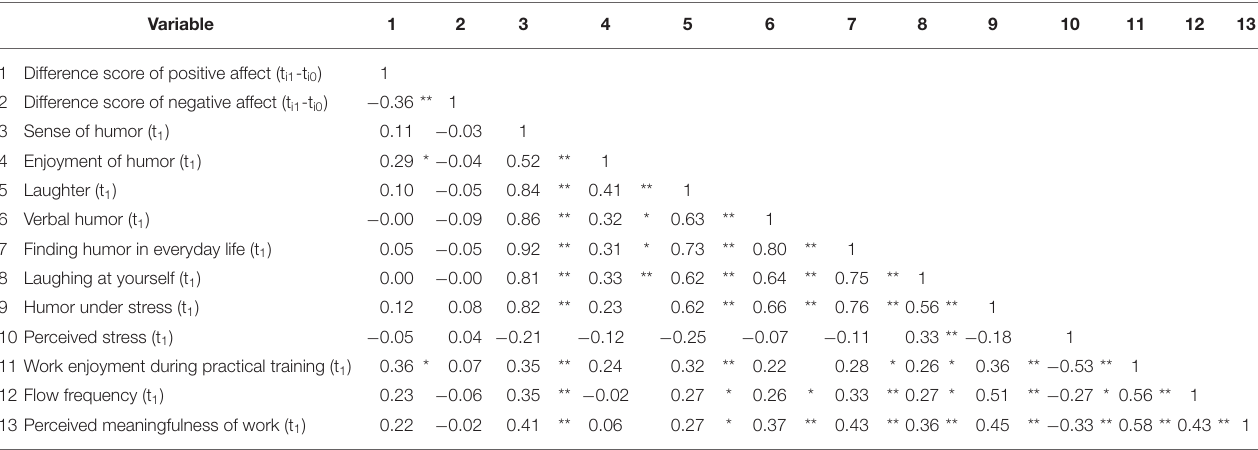
TABLE 5 | Intercorrelation of difference scores of affect at t i with work experience 6 months after the humor intervention. Variable